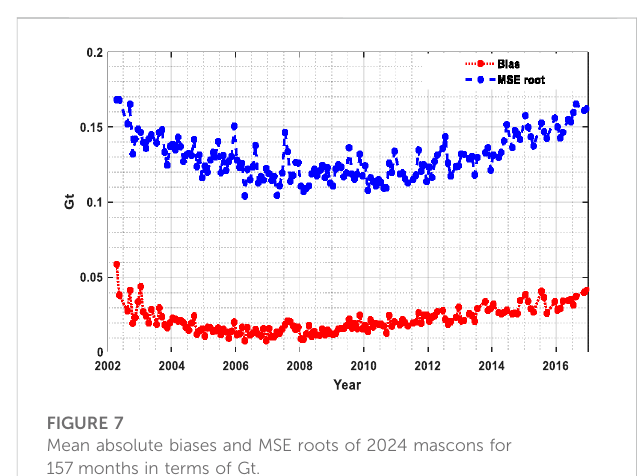
FIGURE 7 Mean absolute biases and MSE roots of 2024 mascons for 157 months in terms of